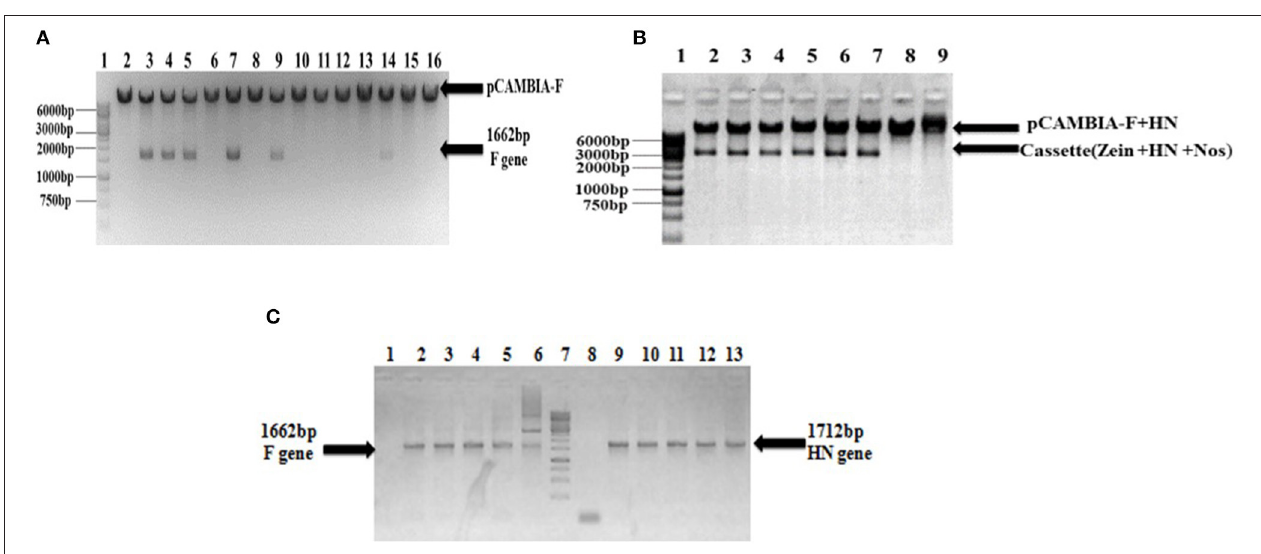
FIGURE 2 | Confirmation of recombinant pCAMBIA F + HN through PCR and restriction digestion. (A) Recombinant plasmid was digested with Nco1 and Bgl11 to confirm the presence of F gene and excised fragment of 1,662 bp confirm the presence of F gene. (B) The whole cassette comprised of HN gene, zein specific promoter and Nos terminator was digested with Sal1 and Kpn1 and excised fragment at 3,366 bp confirmed the presence of whole cassette along with HN gene in recombinant plasmid. (C) PCR analysis of transformed clones. PCR carried with full length F and HN gene specific primers. Lanes 3–6, full-length F gene primer led to 1,662 bp amplified product; Lane 1, shows amplification from non-transformed clones and Lane 2, positive control. Lane 9–12, the full length HN gene primer led to 1,712 bp amplified product; Lane 8, showing amplification from non-transformed clones; Lane 13, positive